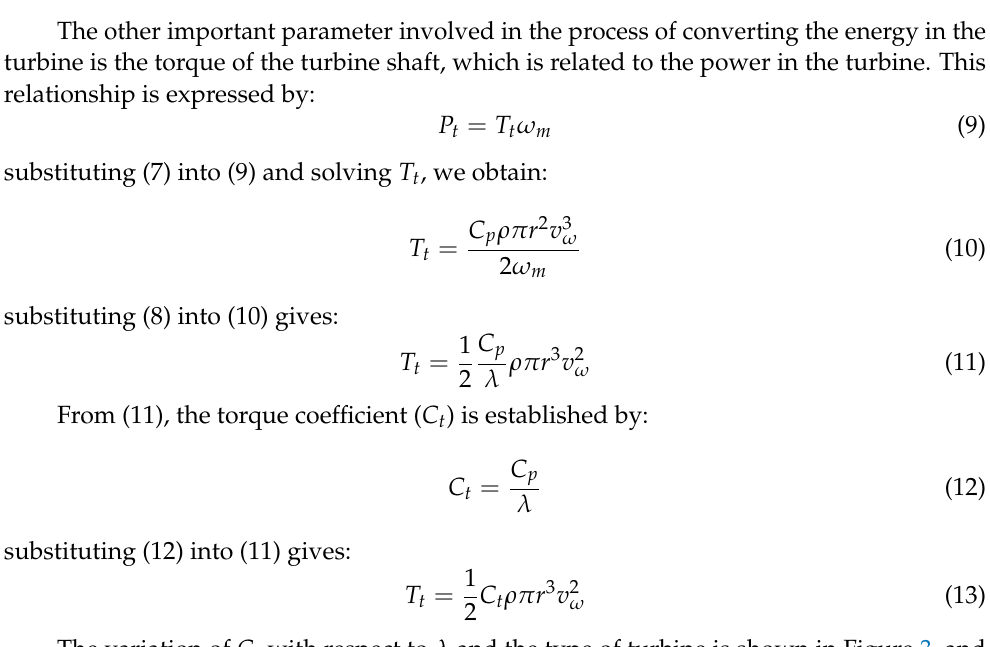
Figure 2. A power coefficient for a specific type of turbine, with variations of 𝜆 and β [17].